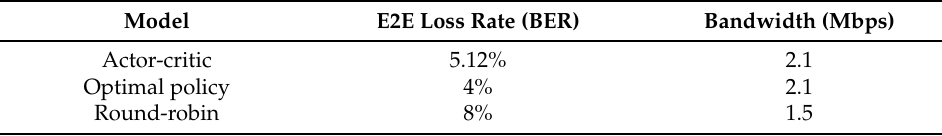
Table 5. E2E loss rate and bandwidth